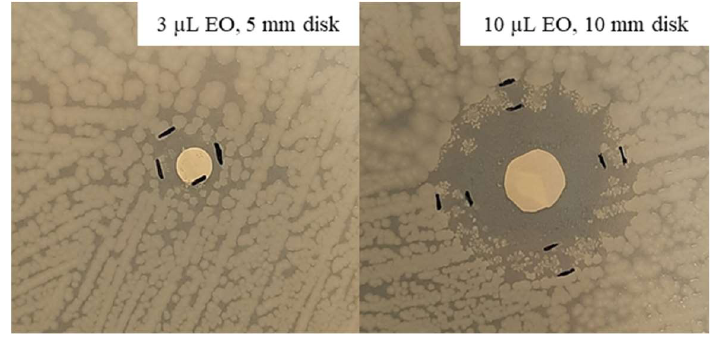
Figure 8. Disk volatilization test set-up with 100% oregano EO against E. coli after 48 h of incubation.